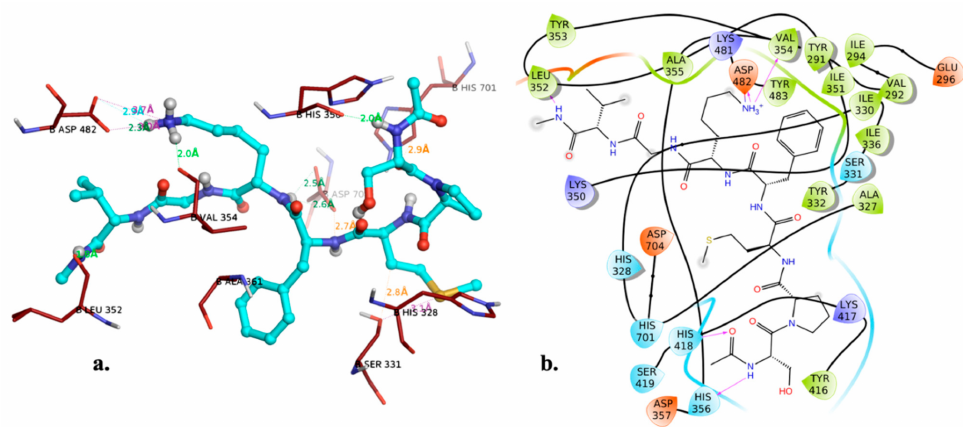
Figure 3. ( a ) Docked pose of peptide inhibitor in the least biding energy conformation along with the interacting residues ( b ) the interaction diagram of PfDegP with peptide